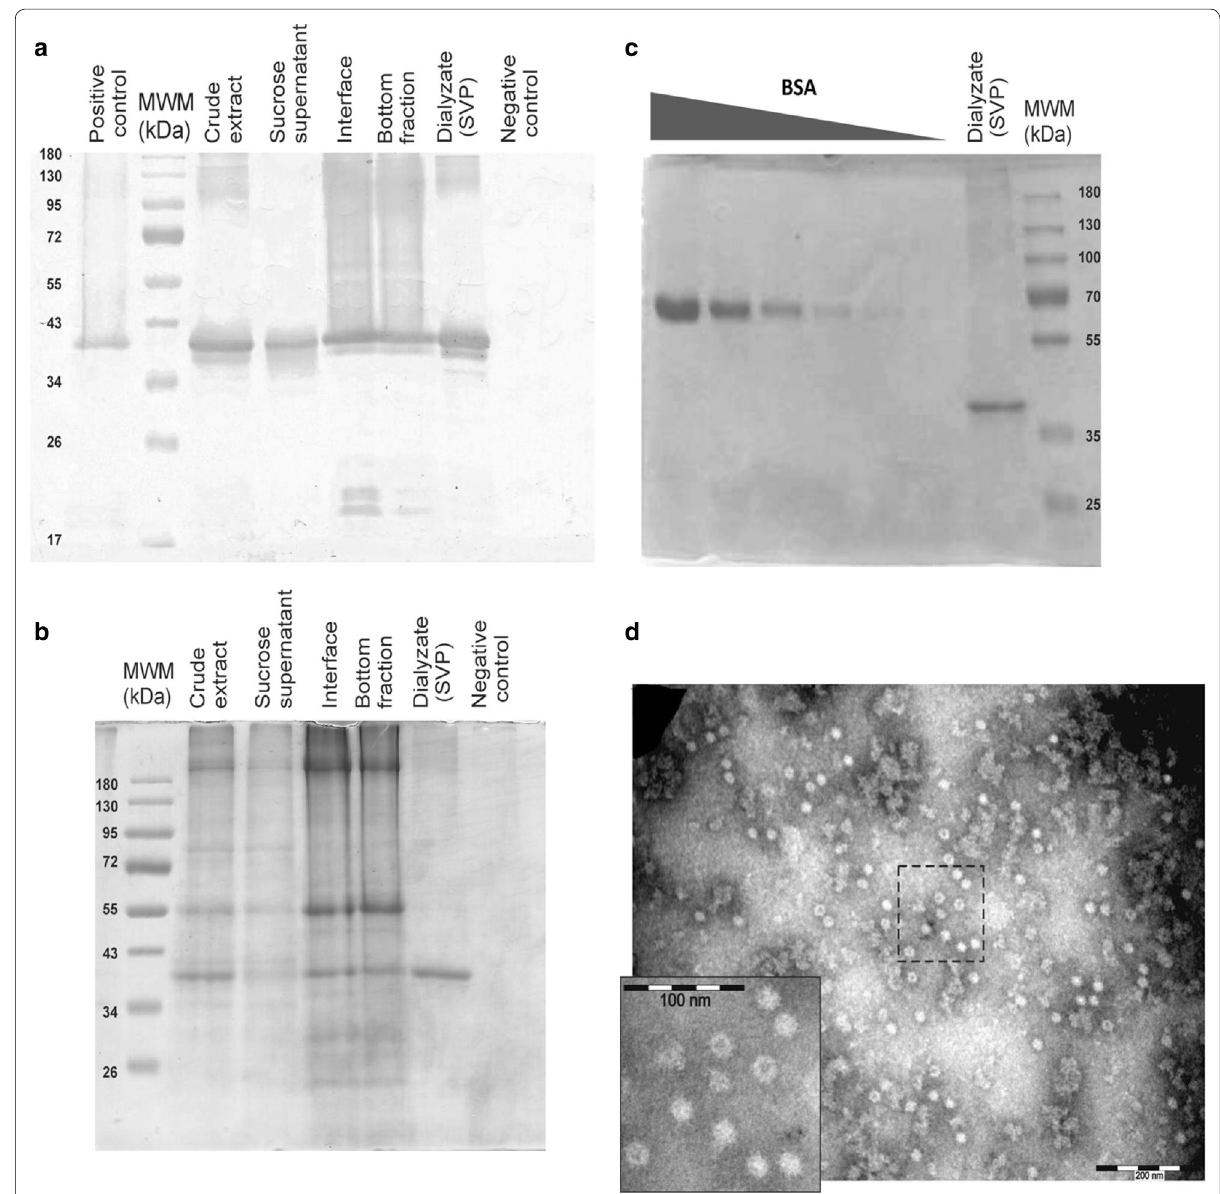
curve of BSA—250, 125, 62.5, 31.25, 15.6 and 7.8 µg/mL—and VP2 were stained with Coomassie blue reagent and the intensity of the bands